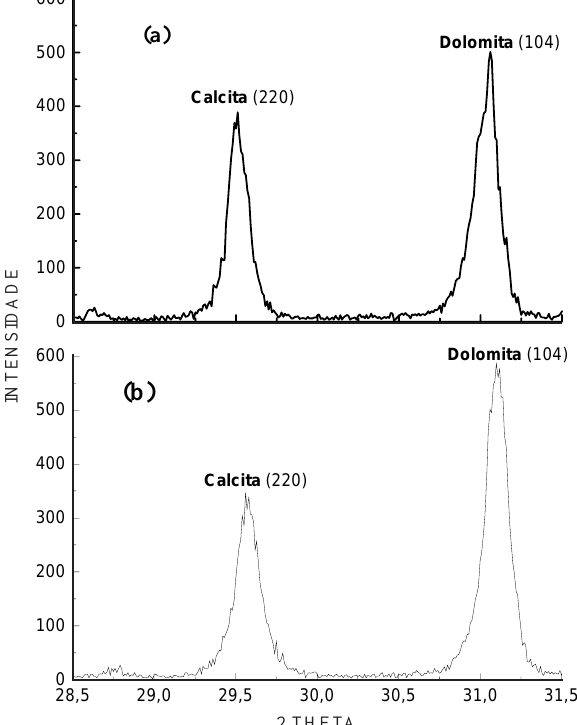
Figura 1. Difratograma de raios-X do calcário dolomítico (a) e das partículas retidas no filtro no fundo da coluna após as primeira adição de água (b). Reflexos nos planos hkl 220 (d = 0,303 nm) de calcita e 104 (d = 0,299) de